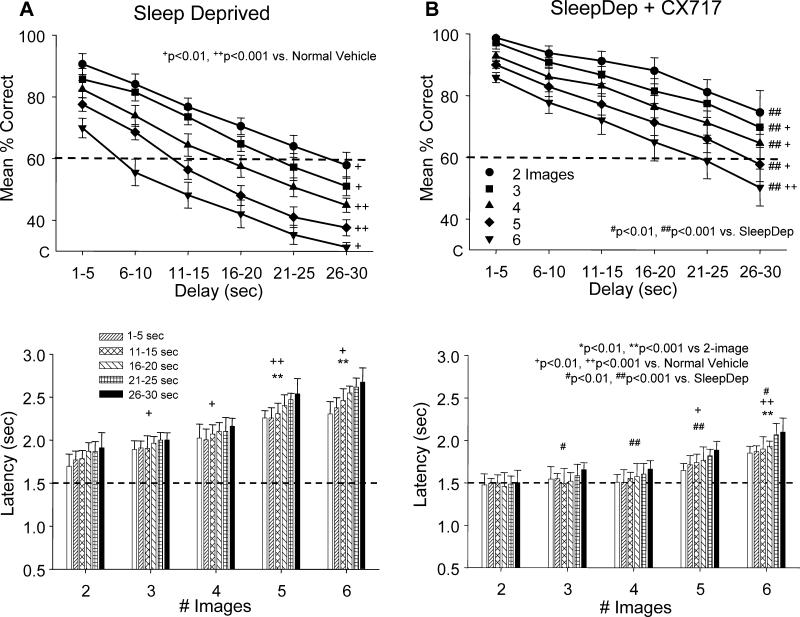
Effects of Sleep Deprivation and Sleep Deprivation + CX717(A) Sleep deprivation condition disrupts DMS performance. Mean percent correct performance across animals for sessions following 30–36 h of sleep deprivation (nine of 11 monkeys in Figure 2A). Plus signs indicate significant mean differences (+
p < 0.01, ++
p < 0.001) compared to the respective number of images curve in the normal vehicle condition; dashed line at 60% allows comparison with Figure 2A.(B) Match response latencies in s (mean ± SEM) sorted for different trial types as in Figure 2B. Asterisks indicate significant difference (*p < 0.01, **p < 0.001) at all delays compared to two-image trials. Plus signs indicate significant differences (+
p < 0.01, ++
p < 0.001) compared to same trial types, and dashed line allows comparison with minimum latencies in normal vehicle condition (Figure 2B).
(C) Sleep deprivation + CX717 condition. Effects of administration of CX717 (0.8 mg/kg, IV) 10 min prior to DMS session following 30–36 h of sleep deprivation. Mean (± SEM) percent correct DMS trials for same delay (1–30 sec, in 5-s increments) and #image (two to six) DMS conditions generated by same monkeys tested in (A). Plus signs indicate significant mean differences (+
p < 0.01, ++
p < 0.001) compared to the respective number of images curve in the normal vehicle condition (Figure 2A); pound signs (#
p < 0.01,##
p < 0.001) indicate significant differences compared to the same trial types in sleep deprivation condition. Dashed reference line allows comparison with sleep deprivation (A) and normal vehicle conditions (Figure 2A).(D) Match response latencies for same sleep deprivation + CX717 condition shown in (C), sorted by delay and number of images and labeled as in Figure 2B. Pound signs (#
p < 0.01, ##
p < 0.001) indicate significant differences compared to the same trial types in sleep deprivation condition (A).DOI: 10.1371/journal.pbio.0030299g004